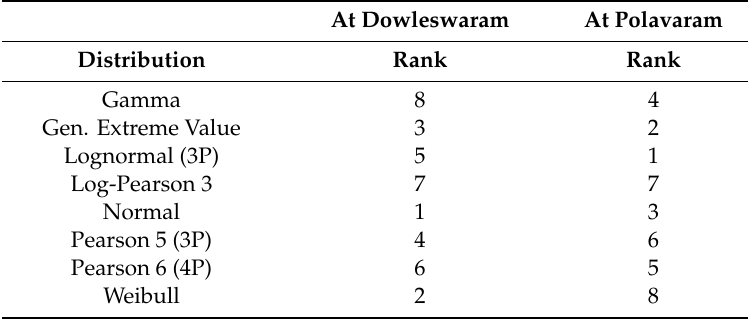
Table 6. Discharge distribution in m 3 / s considered for steady-state analysis at di ff erent reaches. Dowleswaram Polavaram Data River Reach